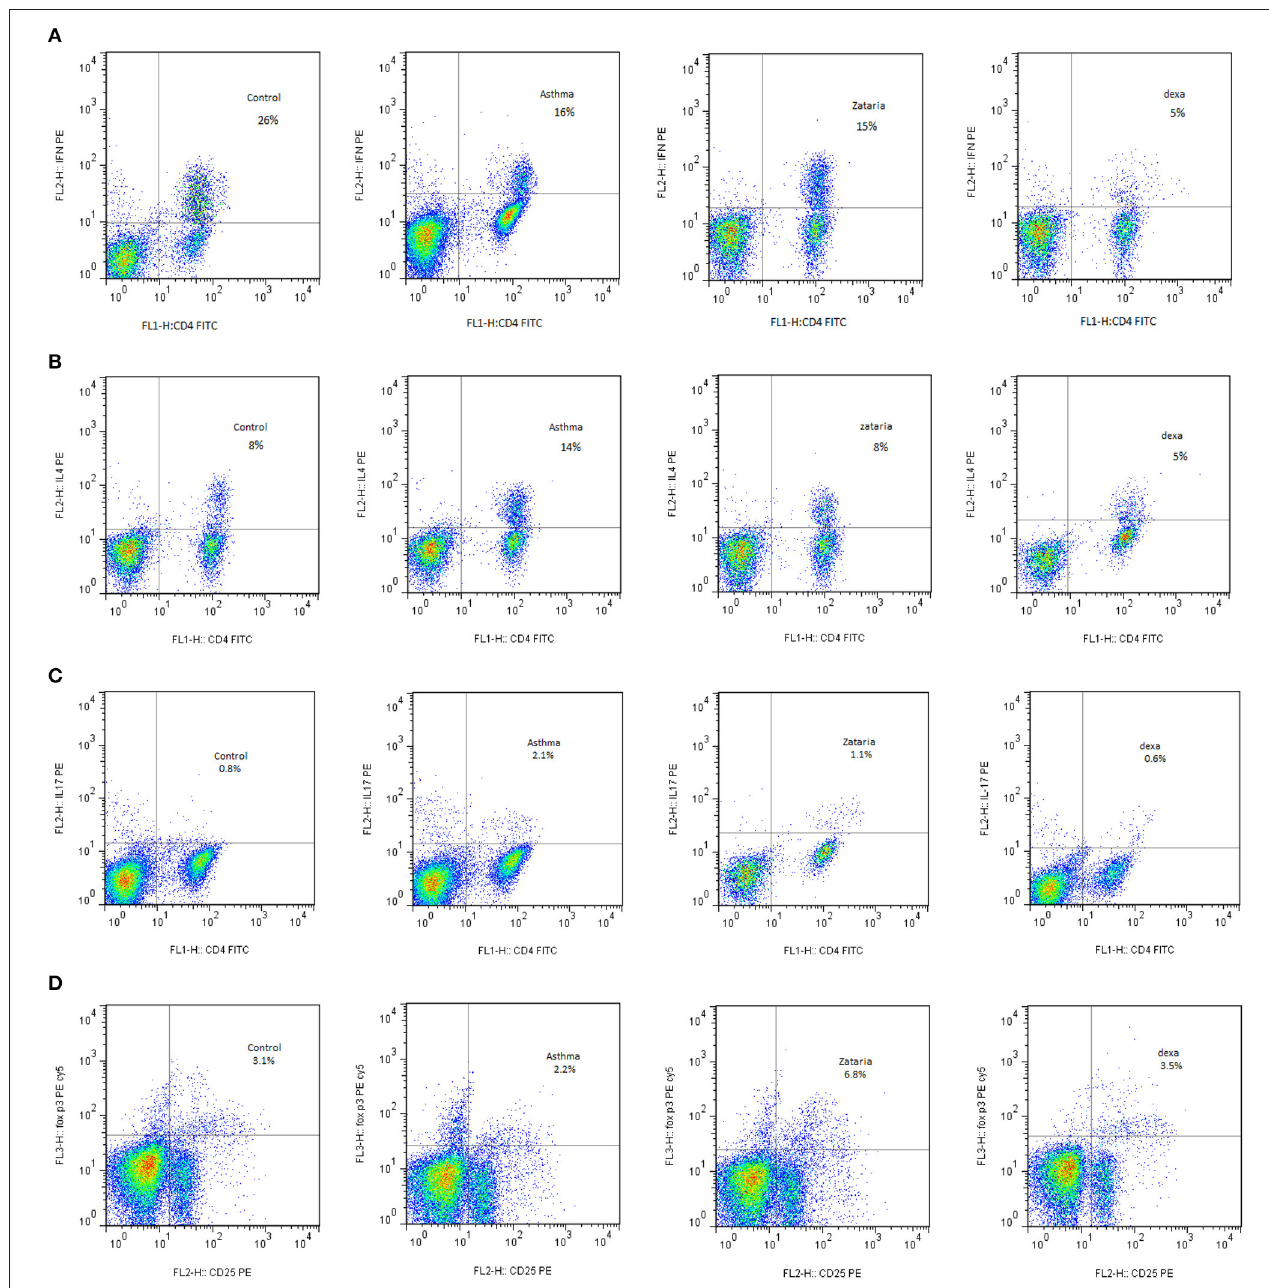
FIGURE 3 | Flow cytometry of various T Cells sub types including; (A) In plot FSC and SSC, Th 1 lymphocyte population between CD4 markers and IFN- γ were selected. The Th 1 in the group treated with extracts in comparison with untreated group increased. (B) In plot FSC and SSC, Th 2 lymphocyte population between the CD4 and IL-4 markers were selected. Th 2 levels in treated groups with extract and dexamethasone compared with untreated group decreased. (C) In the plot FSC and SSC, Th 17 lymphocyte population between the CD4 and IL-17 markers were selected. The Th 17 in the treated groups with extract and dexamethasone compared with untreated group decreased. (D) Treg cells on the lymphocyte population were selected between Sec and CD4. Then this population on CD25 and FOXP3 was placed for determine the amount of these cells. Treg levels in groups treated with extracts and dexamethasone compared with untreated group increased.